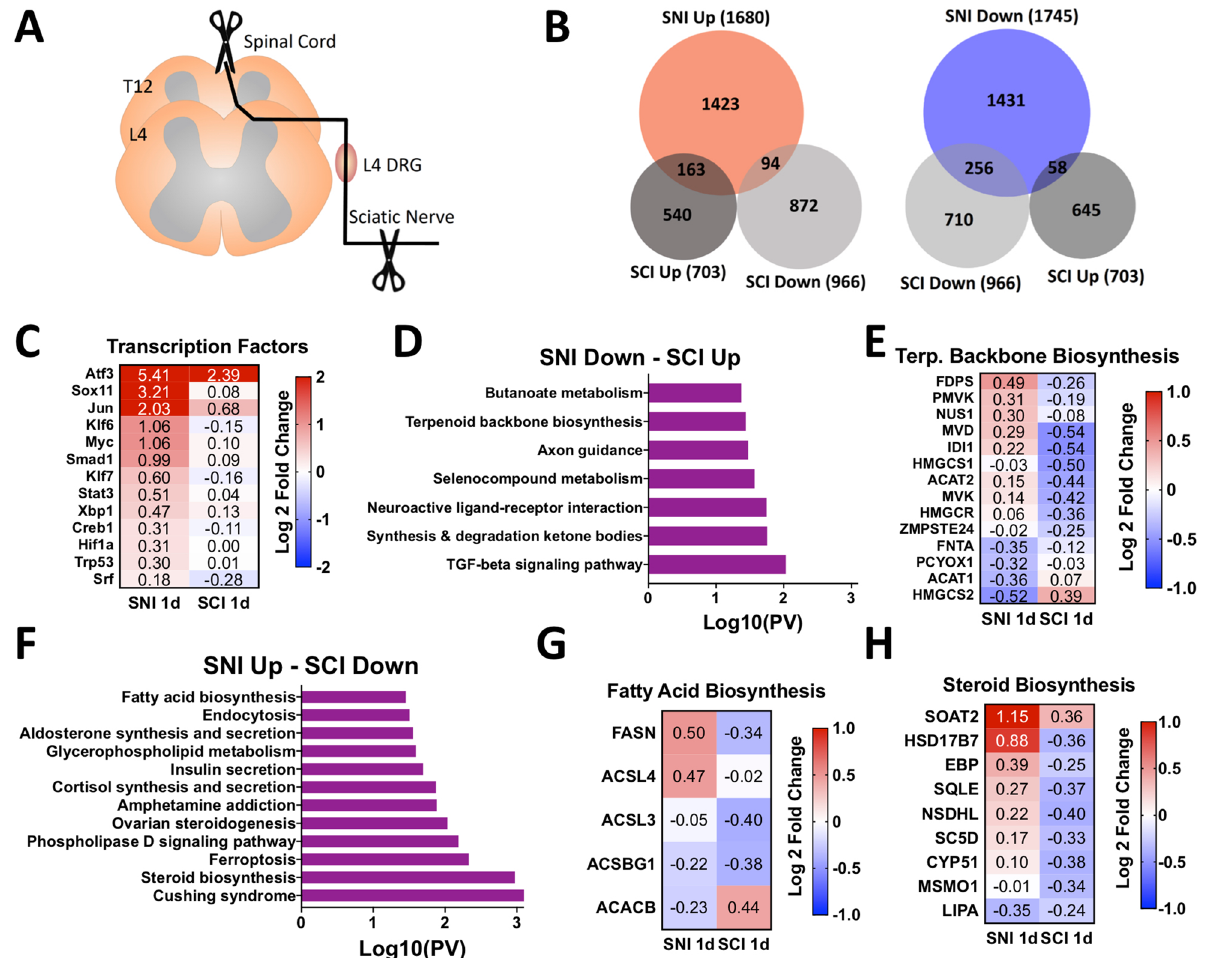
Figure 1. Spinal Cord Injury (SCI) induces an acute transcriptional response in the dorsal root ganglion (DRG) that differs from sciatic nerve injury (SNI). ( A ) Schematic of the experimental design for L4 DRG RNA sequencing after SNI and SCI. ( B ) Proportional Venn diagrams for differentially expressed (DE) genes upregulated (red) or downregulated (blue) after SNI (n = 3 mice) and SCI (n = 4 mice) ( p -adj < 0.1). ( C ) Heatmap of known regeneration-associated transcription factors (RATFs) after SNI and SCI. ( D ) KEGG pathway analysis 17–19 of DE genes downregulated after SNI and upregulated after SCI. ( E ) Heatmap of genes associated with terpenoid backbone biosynthesis after SNI and SCI. ( F ) KEGG pathway analysis 17–19 of DE genes upregulated after SNI and downregulated after SCI. ( G , H ) Heatmap of genes associated with fatty acid biosynthesis and steroid biosynthesis after SNI and